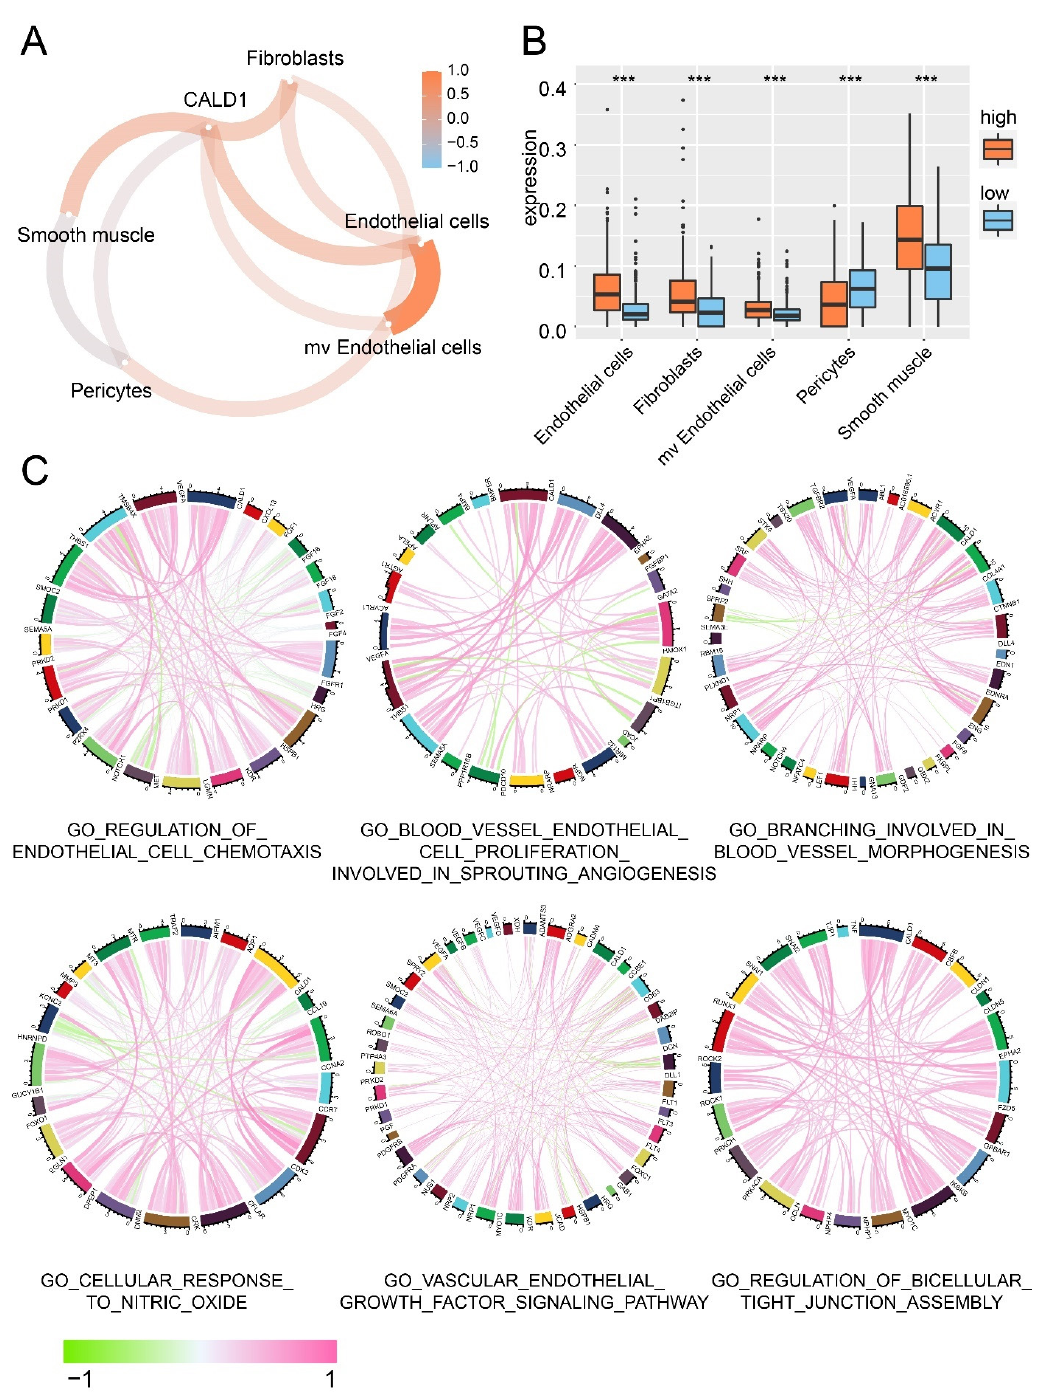
Figure 2. Stromal cells proportion in tumor microenvironment. ( A ) The correlation between CALD1 expression and the enrichment score of stromal cells. ( B ) The distribution of stromal cells in high and low CALD1 expression samples. ( C ) The correlation between the expression of CALD1 and genes from GO pathways. NS: no statistical difference; *: p value < 0.05; **: p value < 0.01; ***: p value < 0.001.